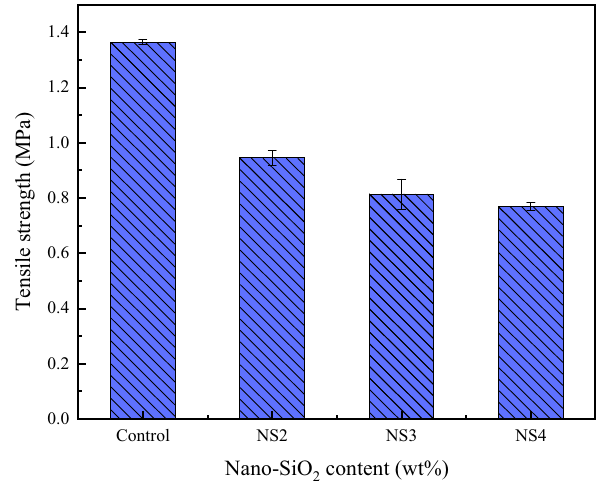
Figure 11: Maximum tensile strength of geopolymer mortar supple - mented with nano - SiO 2 [ 87 ]